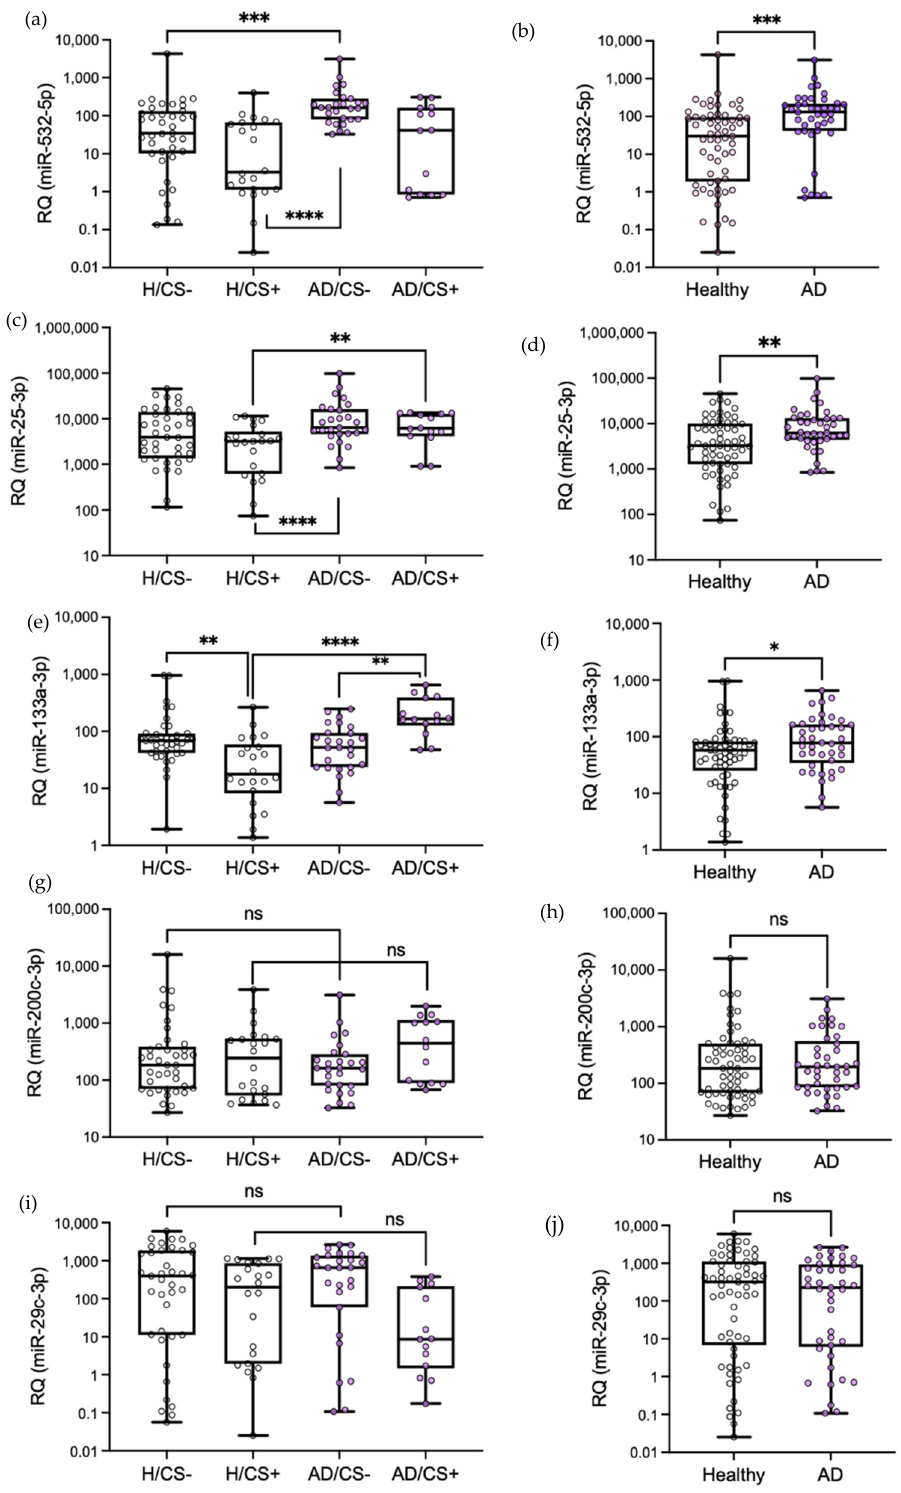
Figure 2. Validation of differentially expressed miRNAs in AD patients compared to healthy controls according to ( a – e ) cigarette-smoking status, and ( f – j ) study group. Statistically significant differences were indicated as * p < 0.05, ** p < 0.01, *** p < 0.001, **** p < 0.0001, and ns = no statistical significance, according to Kruskal–Wallis test with Dunn’s post hoc test, followed by Mann–Whitney U test for pairwise comparisons. RQ, relative expression; AD, adenocarcinoma; CS, cigarette smoking; H, healthy controls. RQ values are presented in logarithm base 10 scale.